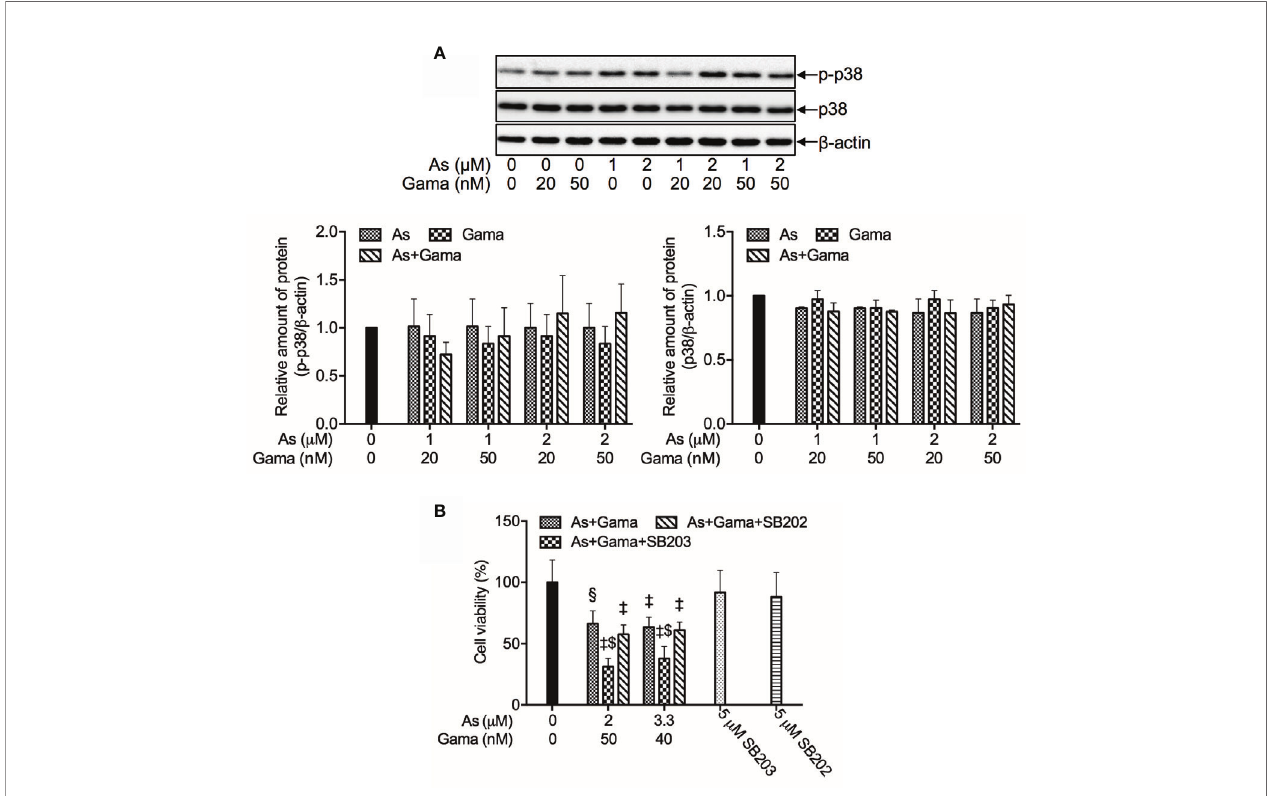
FIGURE 7 | Prosurvival role of p38 MAPK in the cytotoxicity of U-87 cells treated with the combination of As III and gamabufotalin. (A) Following treatment for 48 h with relatively low concentrations of As III (1, 2 m M) and gamabufotalin (20, 50 nM), alone or in combination, the expression pro fi les of phospho-p38 (p-p38) and p38 were analyzed using western blotting. A representation image of the expression pro fi le of each protein is shown from three independent experiments. The expression levels were expressed as the ratios between each targeted protein and b -actin protein expression levels, and were compared with those of control group. (B) Following treatment for 48 h with the combined regimen of 2 m M As III + 50 nM gamabufotalin; 3.3 m M As III + 40 nM gamabufotalin, in the presence of absence of 5 m M SB203580, a speci fi c inhibitor for p38 MAPK and its negative control SB202474, cell viability was determined by XTT assay. Relative cell viability was calculated as the ratio of the absorbance at 450 nm of each treatment group against those of the corresponding untreated control group. Data are shown as the means ± SD (n ≥ 3). A p value less than 0.05 was considered as statistically signi fi cant ( § p < 0.001; ‡ p < 0.0001 vs. control. $ p < 0.001 vs. As+Gama and As+Gama+SB202474). As, As III ; Gama, gamabufotalin; SB203, SB203580; SB202, SB202474. The images of beta-actin are identical to that in Figure 4B since the same experiment samples were used to